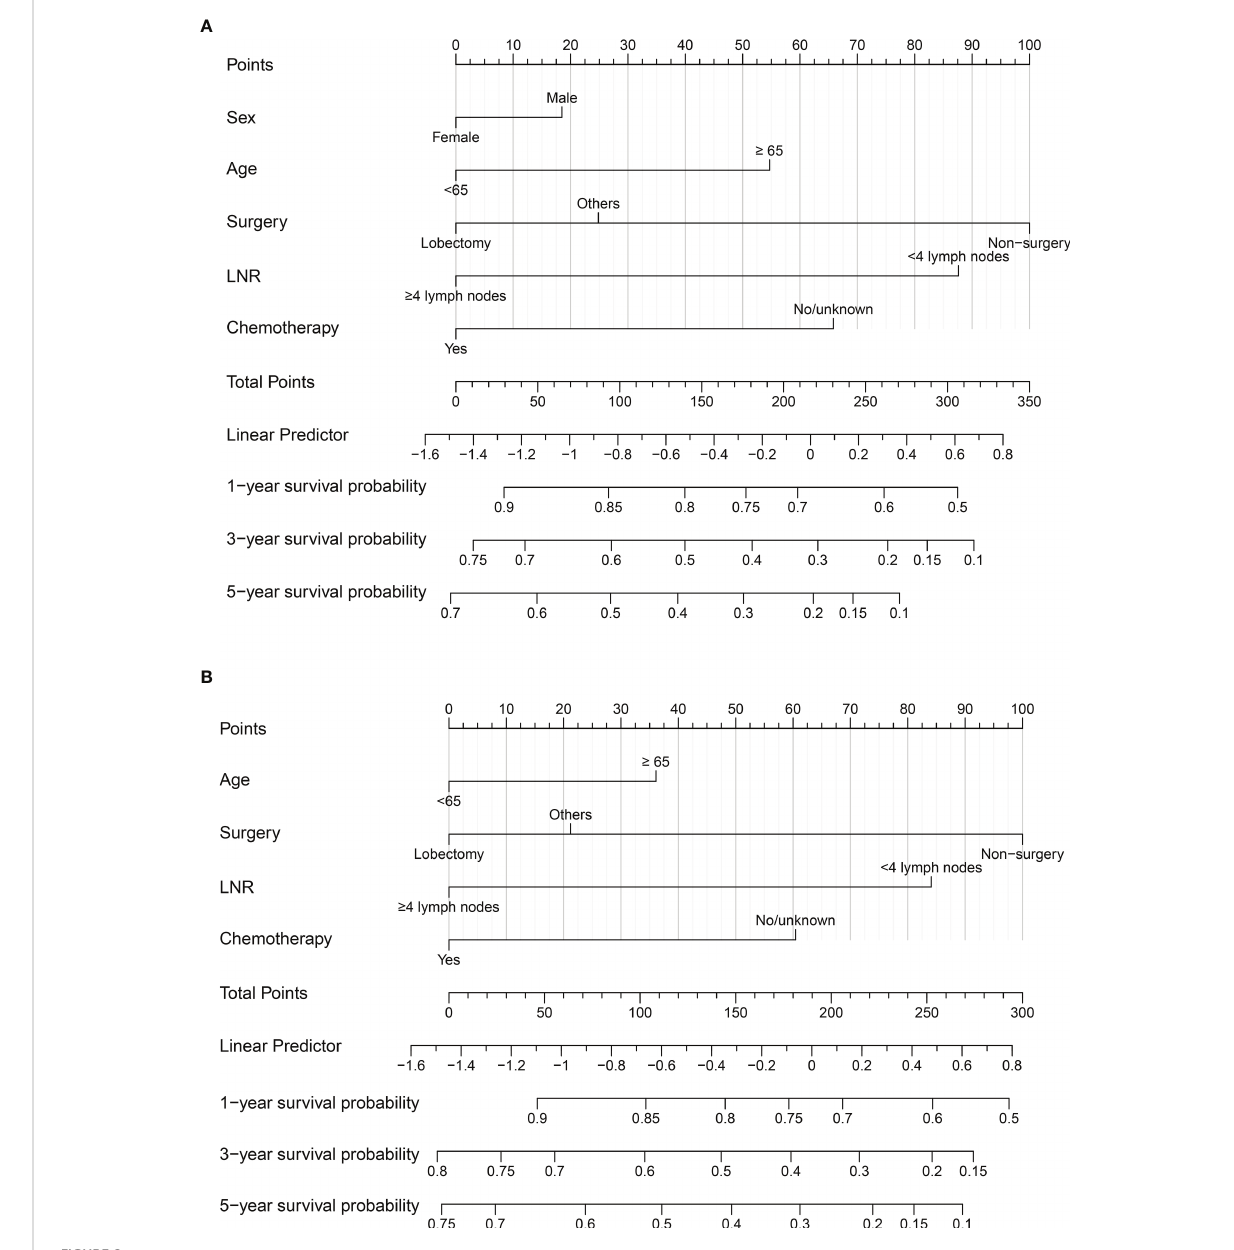
Figures 8A, 9A). Signi fi cant differences in OS and LCSS were also observed between almost all subgroups when patients were strati fi ed by AJCC stages (P <0.001, Figures 8B – D, 9B – D). The same grouping method was then applied to the validation cohort, and signi fi cant distinctions in survival curves for OS and LCSS between the two different risk groups were also